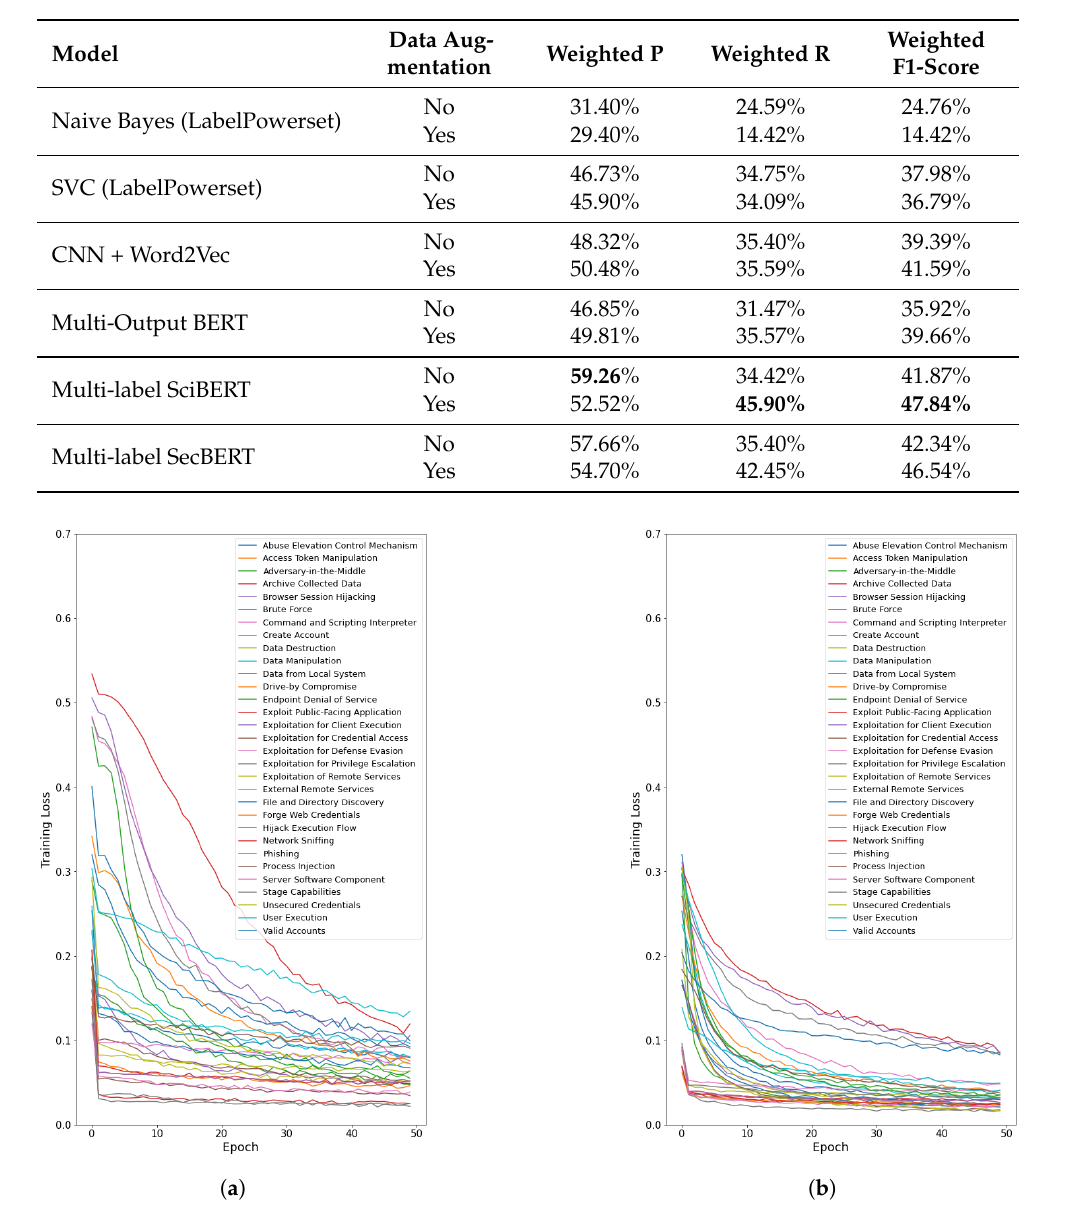
Table 2. Side-by-side comparison of performance with and without data augmentation (bold denotes the best model).